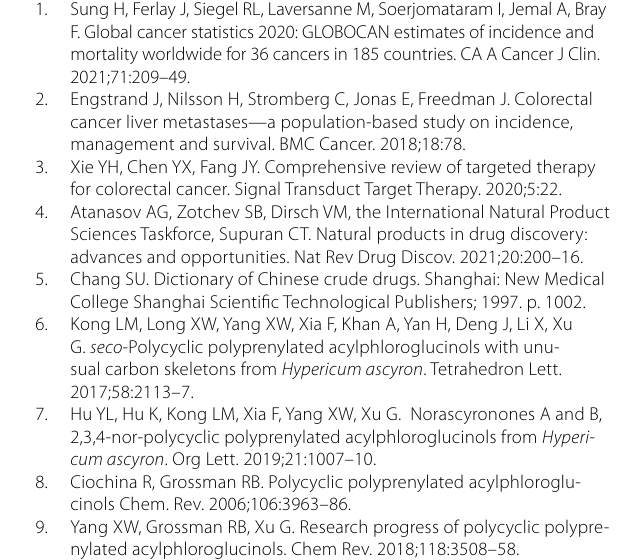
a Data were expressed as mean b 5-FU was used as a positive